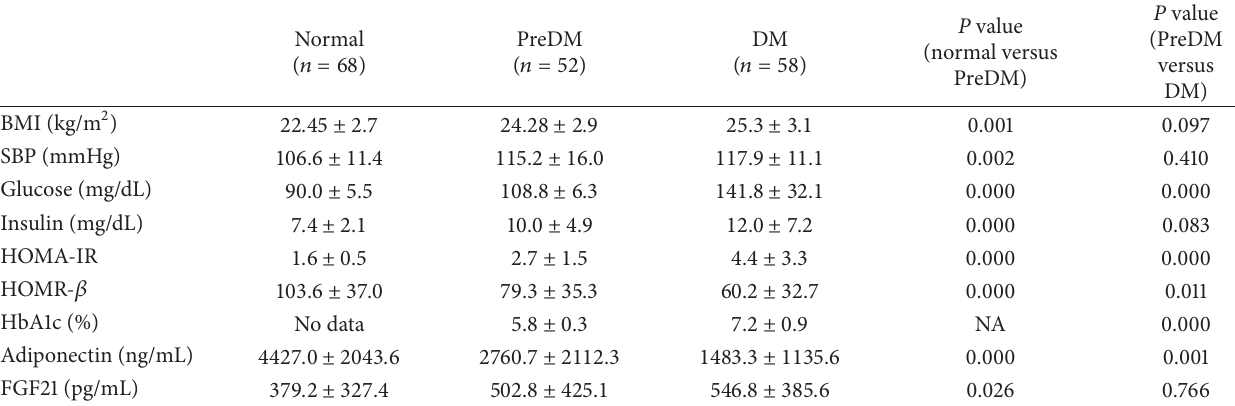
Table 1: Baseline characteristics of study participants.